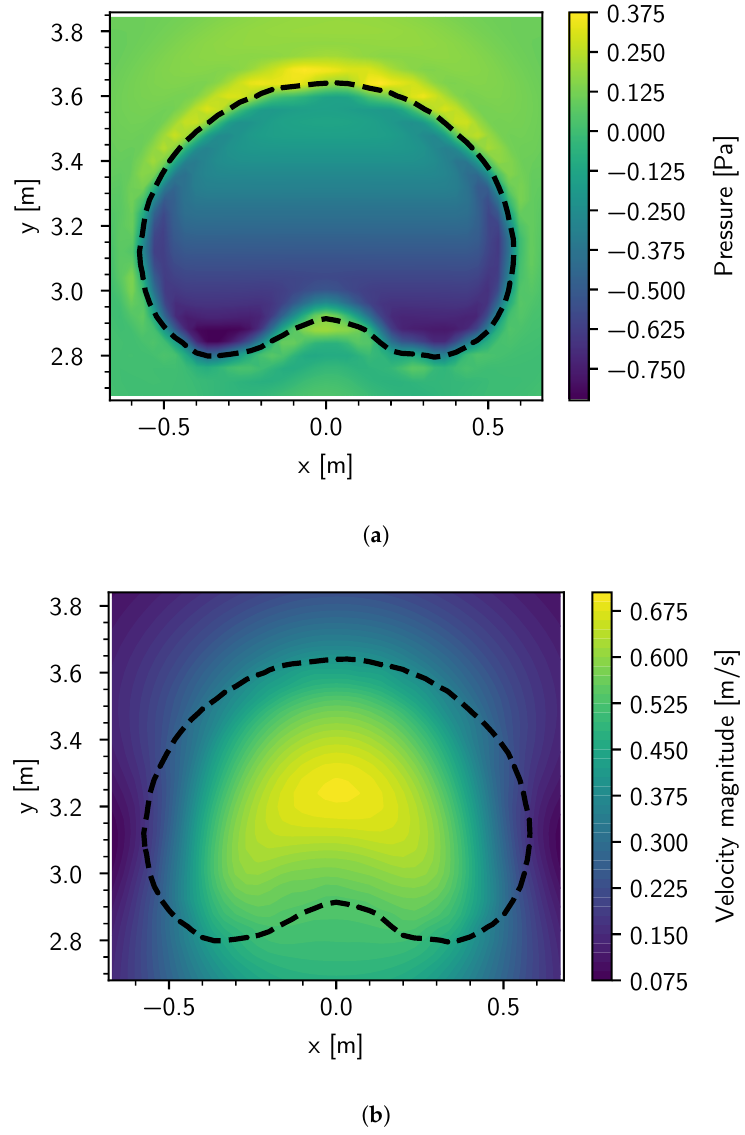
Figure 11. Mid-plane continuum results for the rising bubble Case 2, showing ( a ) the pressure field and ( b ) the velocity field at t = 4.0 s.